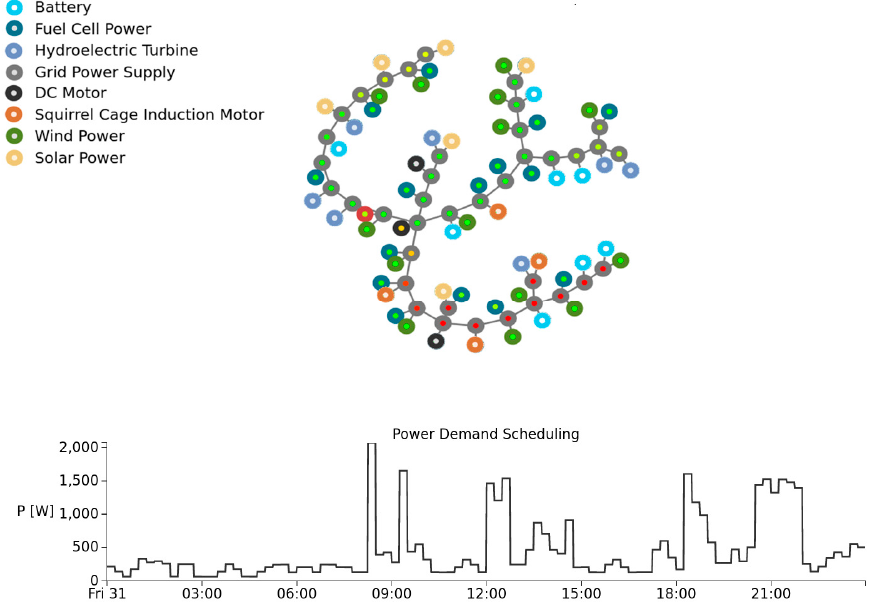
Figure 25. Mosaik co-simulation: Global Power Demand.